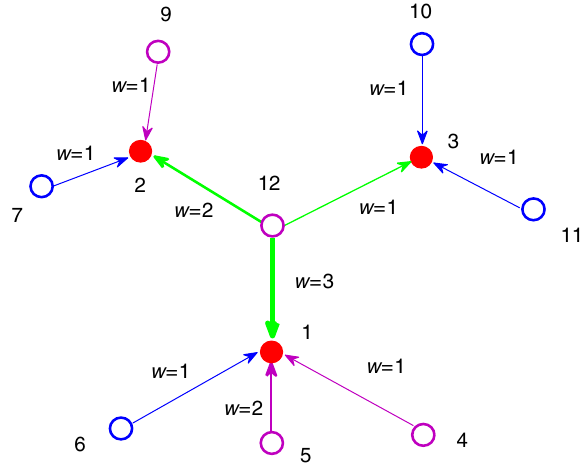
FIG. 9. Estimation of f min